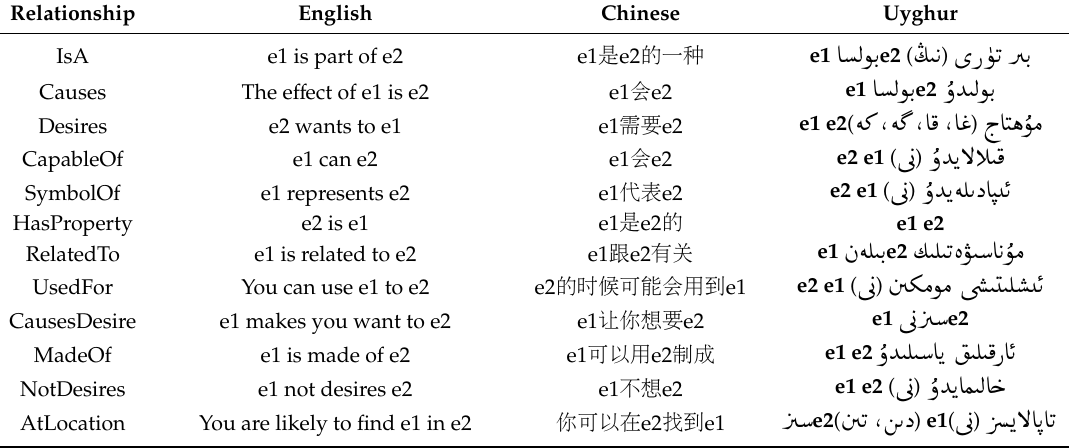
Table 1. Templates for converting Chinese and Uyghur facts into phrases. The English templates were developed by ConceptNet organizers (https: // github.com / commonsense / conceptnet5 / wiki). The content in parentheses after the entity in the Uyghur template represents the variations of a ffi x in the Uyghur